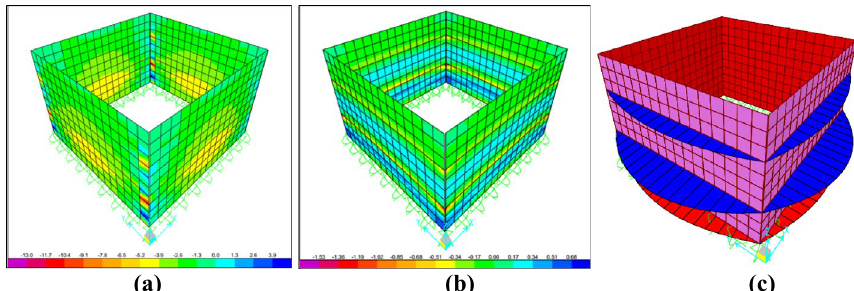
Fig. 9 Straining actions in plexiglass using SAP2000 ( a ) force F11, ( b ) bending M22, and ( c ) bending M33 on steel channels supporting